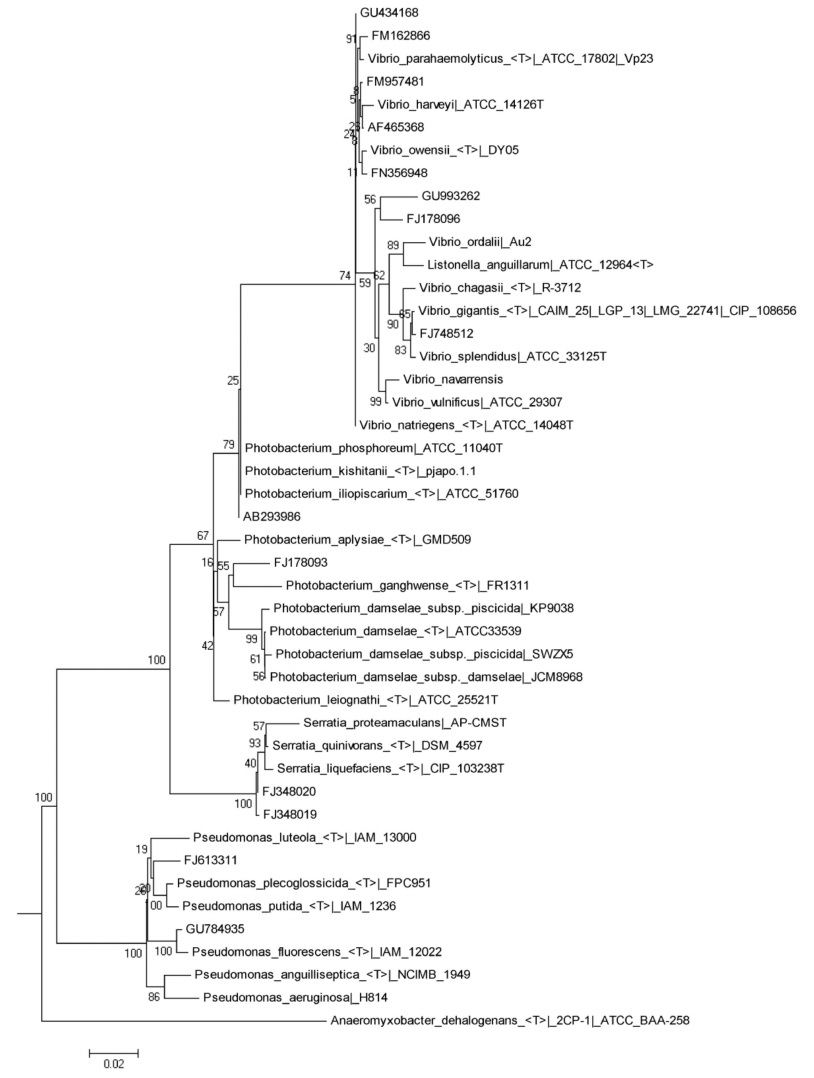
Figure 3. Phylogenetic tree of clusters based on 16S rRNA sequences showing the relationships of the predominant bands obtained from intestinal samples of juvenile S. aurata with their closest species of Vibrio , Photobacterium , Pseudomonas , and Serratia